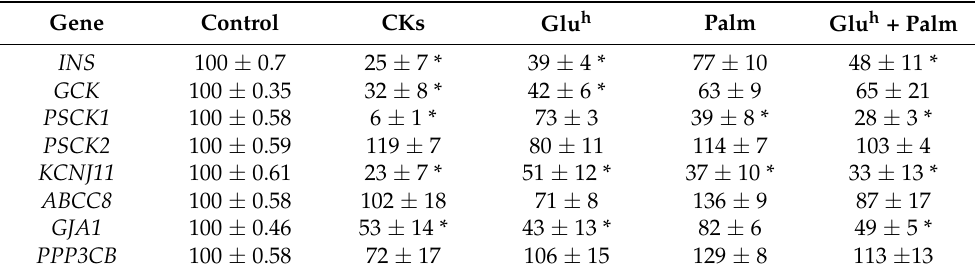
Table 1. Cytokines, palmitate, high glucose, and high glucose+palmitate effect on the expression of secretory function related genes as measured by the real-time quantitative PCR reaction. Results are presented as the mean ± SEM of mRNA expression indicated as arbitrary